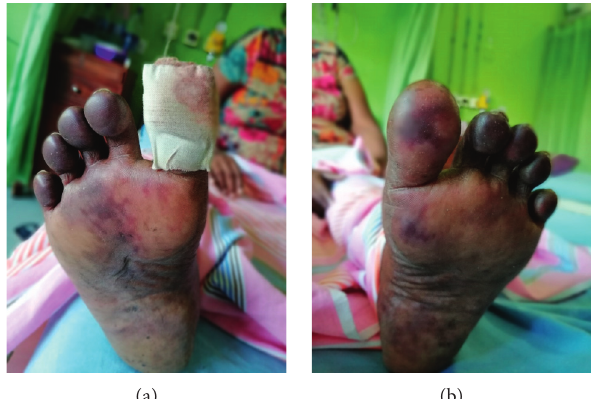
Figure 1: Patient’s feet showing retiform purpura and evidence of digital ischemia.